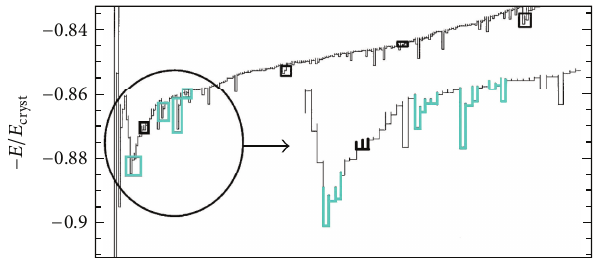
Figure 1: (Color online) The energy landscape (for 𝜌 = 1 Lennard-Jones density, adapted from [36]) of a toy glass model, with highlighted multiwelled potentials (black the 2LS, light blue the 3LS, 4LS, ...